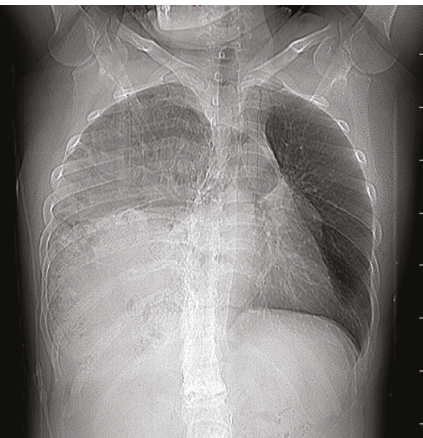
Figure 1: Chest X-ray. Right lung was pushed upwards and right hemithorax was filled with